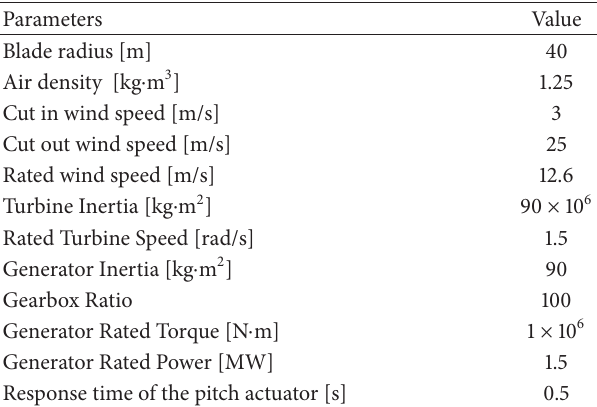
Table 2: Nominal Parameters of the